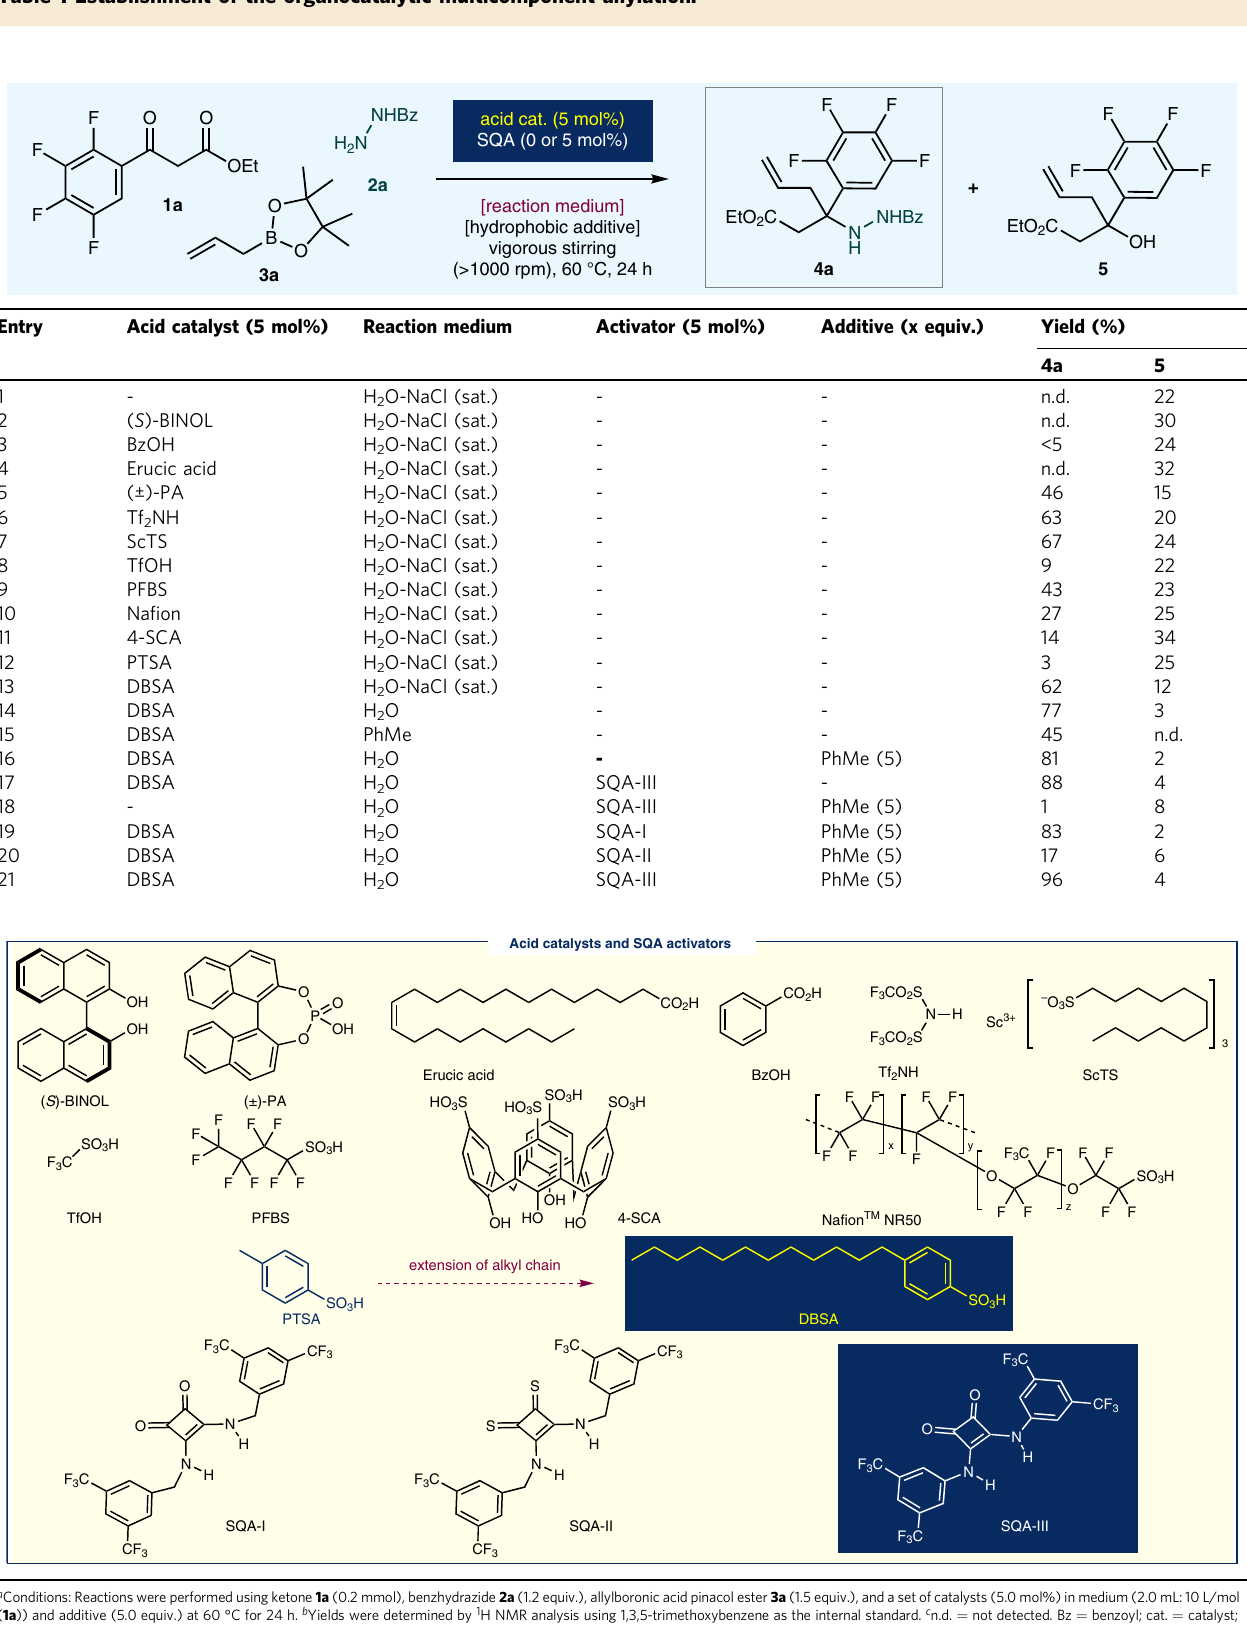
Table 1 Establishment of the organocatalytic multicomponent